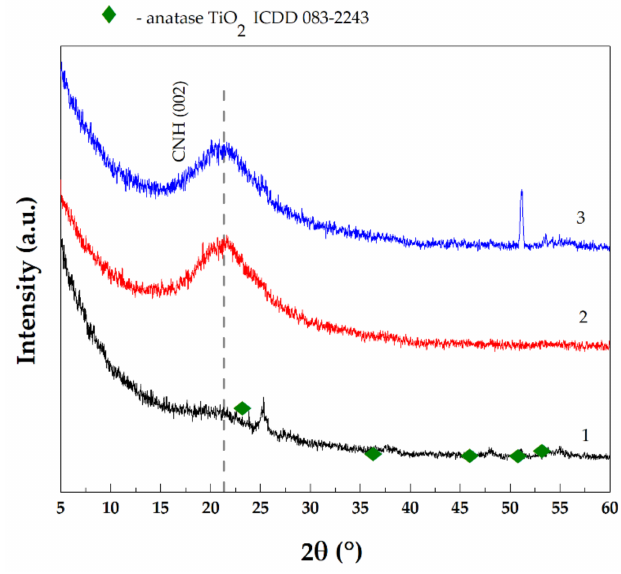
Figure 8. X-ray diffraction pattern for solid-state films of the CNHox/TiO 2 /PVP nanocomposite with weight ratios ( w/w/w ) of (1) 1/1/1 (black line), (2) 2/1/1 (red line), and (3) 3/1/1 (blue line).